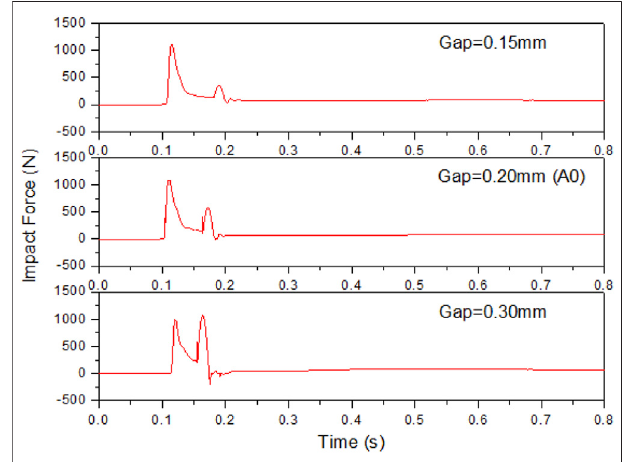
FIGURE 5 | The effects of piston unilateral gap on the real-time impact